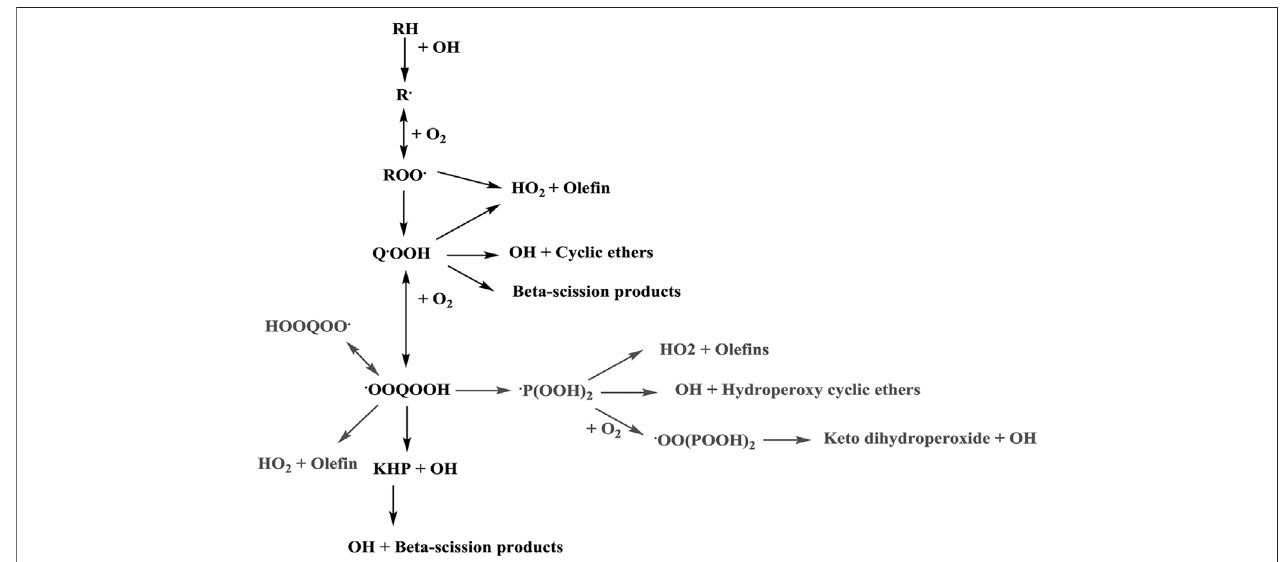
FIGURE 5 | General fuel consumption pathway (Atef et al., 2017).